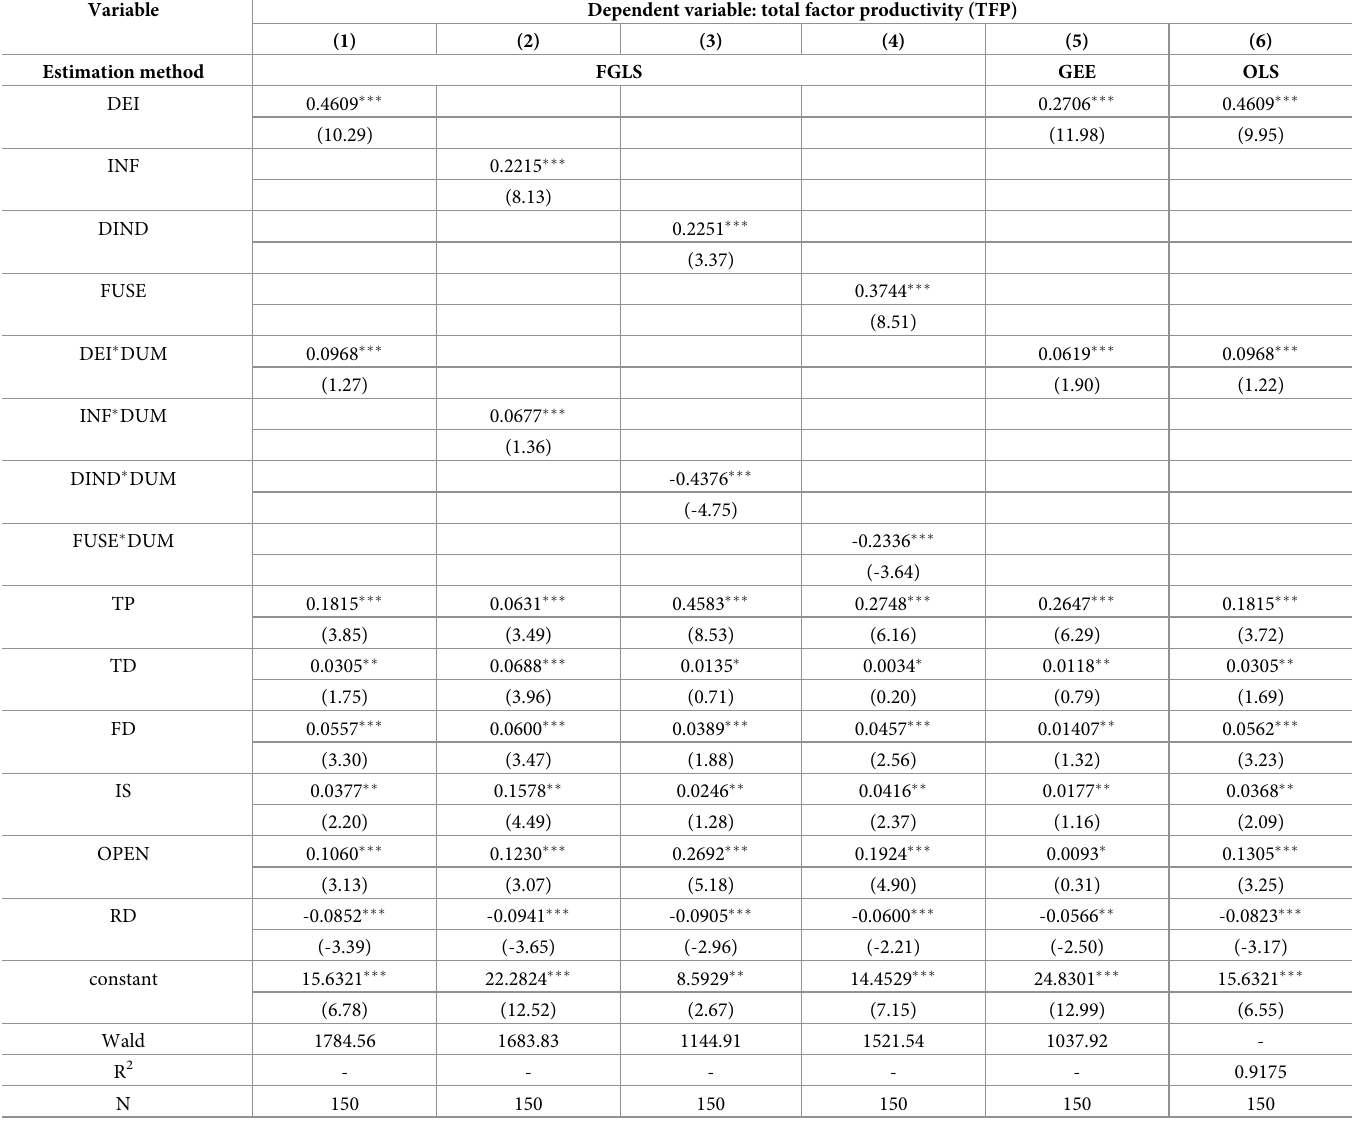
Table 8. Regression results of the digital economy index and its three sub-indexes and regional interaction items.